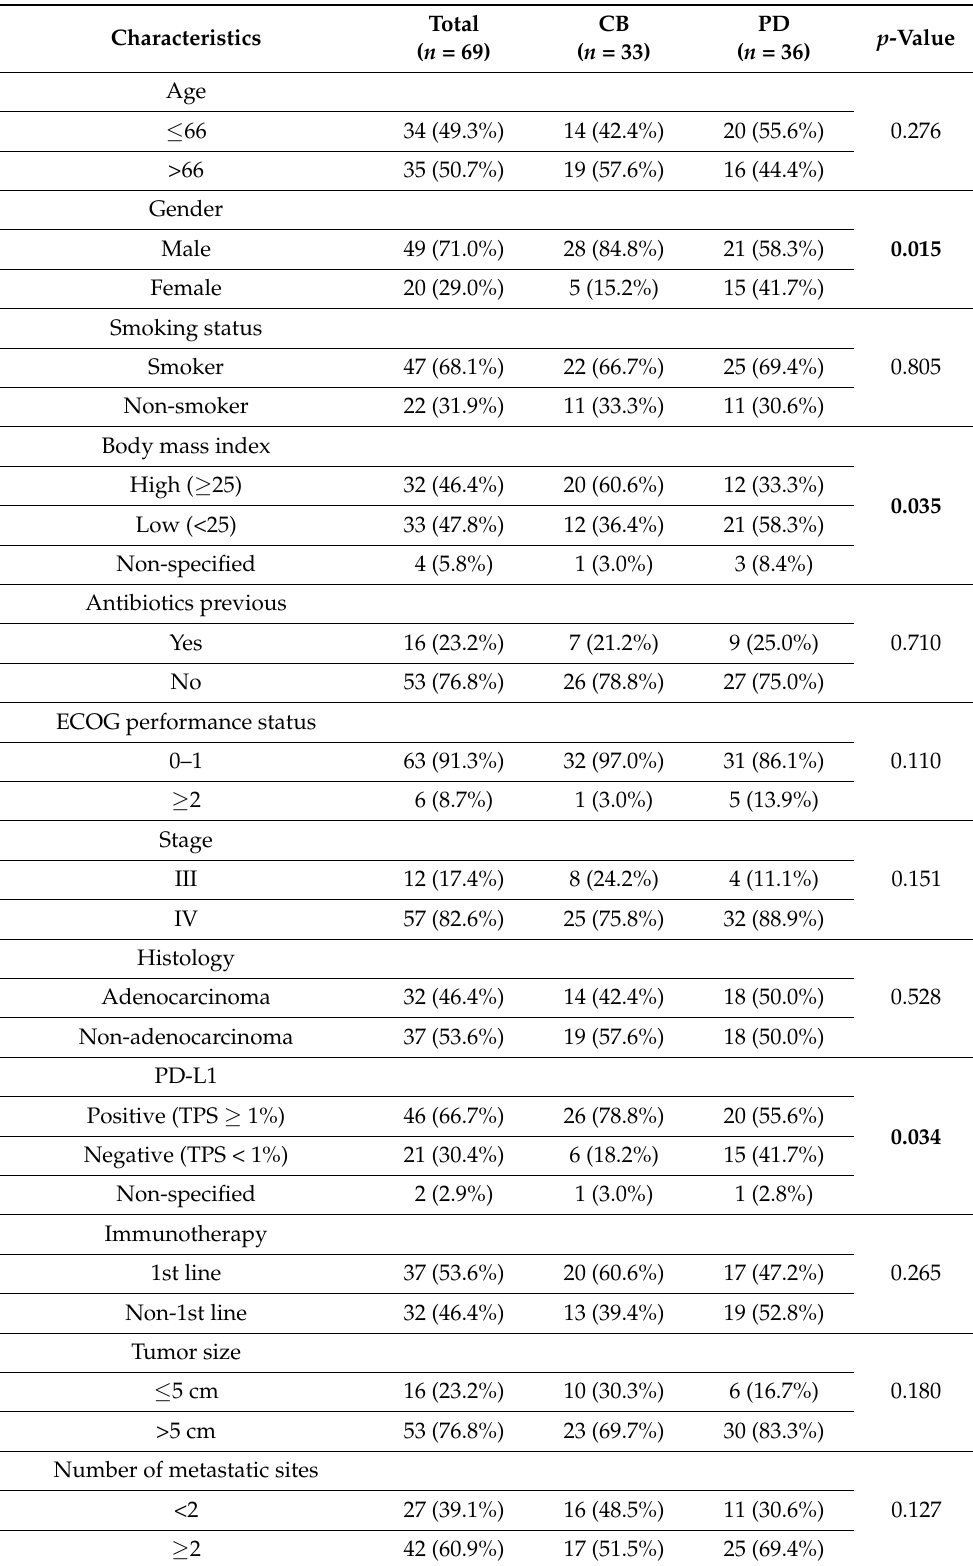
Table 1. Baseline clinico-pathological characteristics of patients and correlation with response to